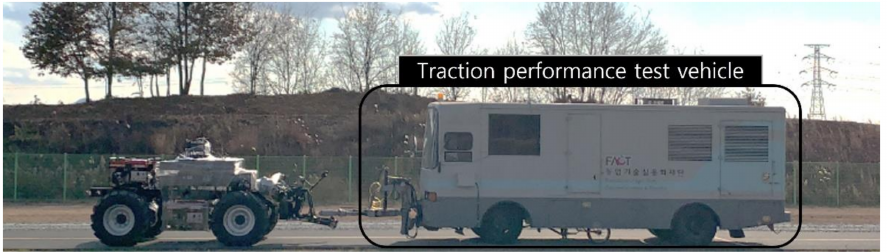
Figure 4. Traction test of the electric AWD tractor using traction performance test vehicle on a concrete